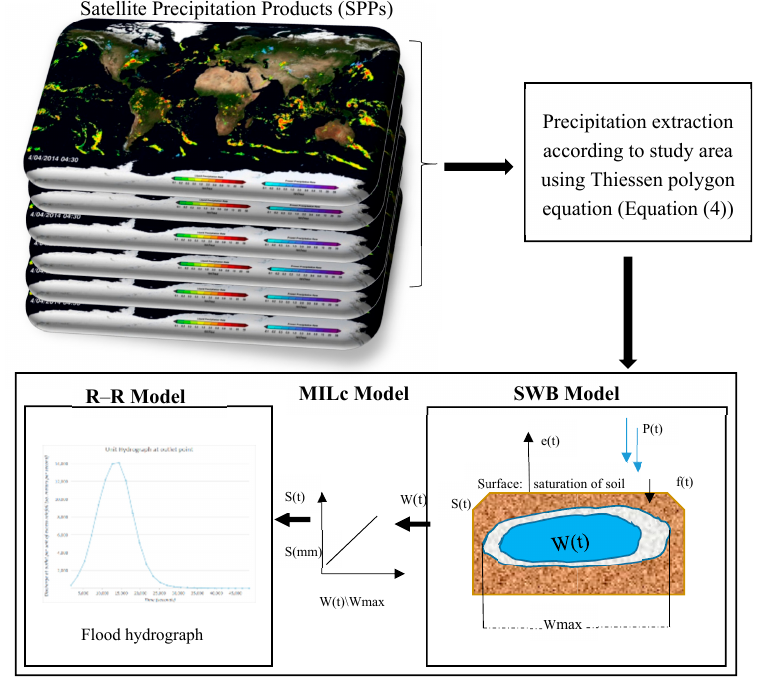
Figure 6. Hydrological forecasting framework using the MILc model adapted to SPPs. Notations in the Soil–Water Balance model (SWB): e(t) = evapotranspiration, f(t) = infiltration, s(t) = saturation excess, p(t) = precipitation, w(t) = wetness and w max = maximum wetness.